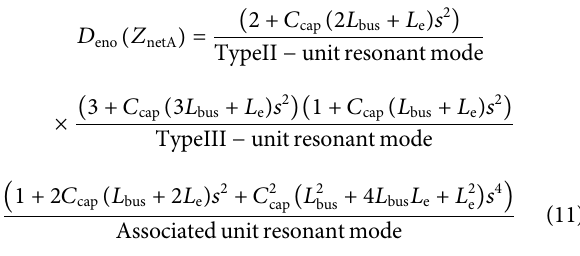
FIGURE 7 | Impact of parameter variation on resonant